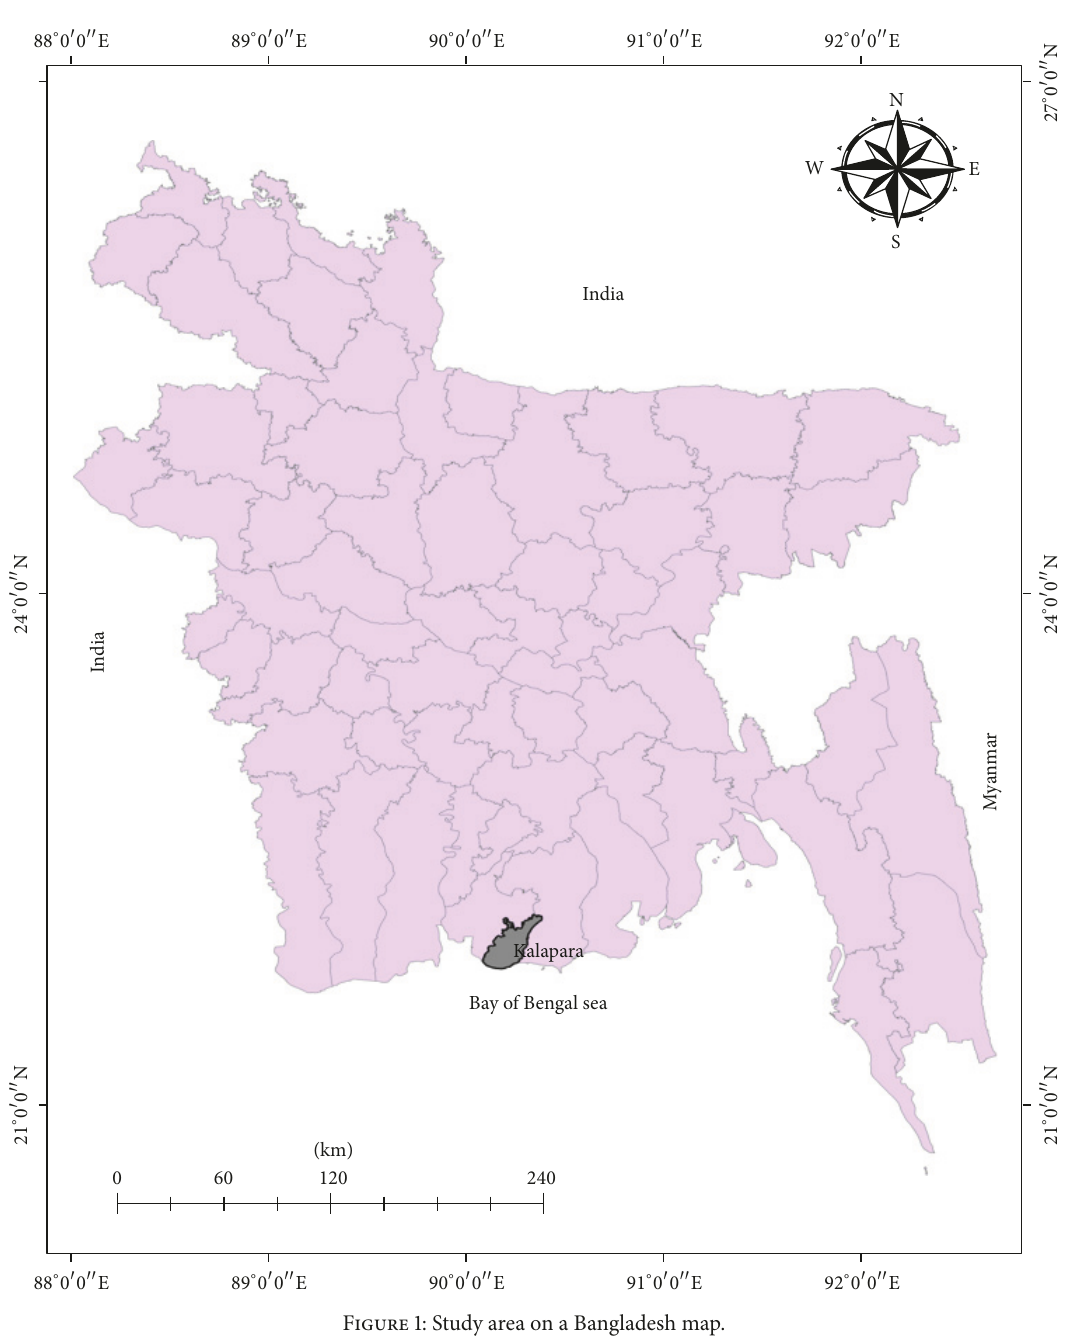
Figure 1: Study area on a Bangladesh